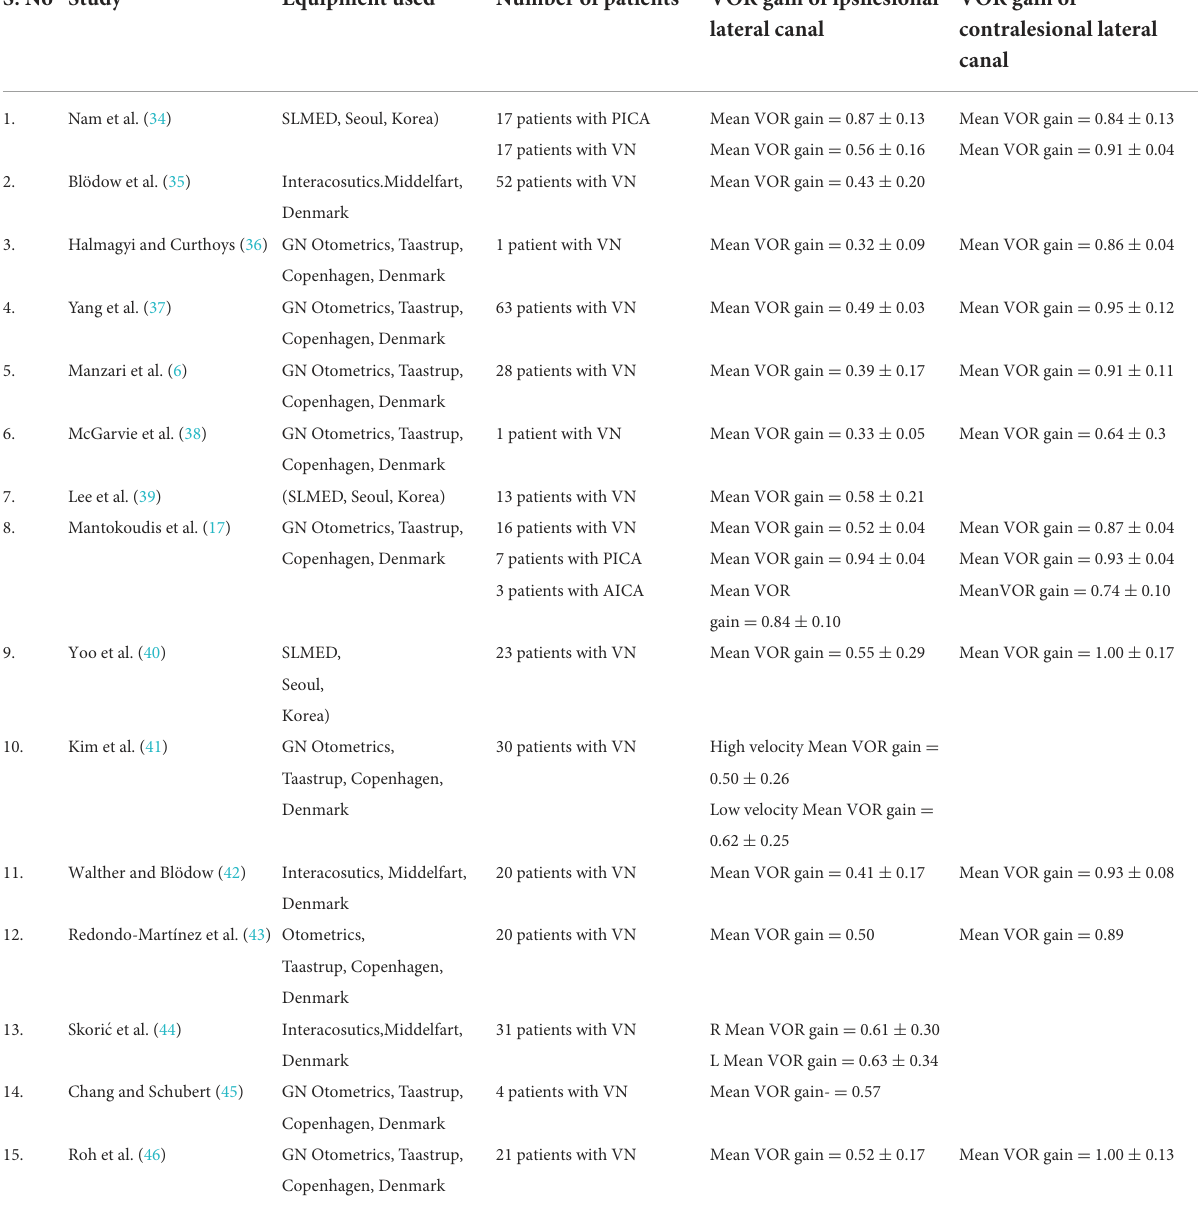
VN,Vestibularneuritis;AICA,Anteriorinferiorcerebellarartery;PICA,Posteriorinferiorcerebellarartery;SD,standarddeviation;V-OR,Vestibulo-Ocularreflexgain.